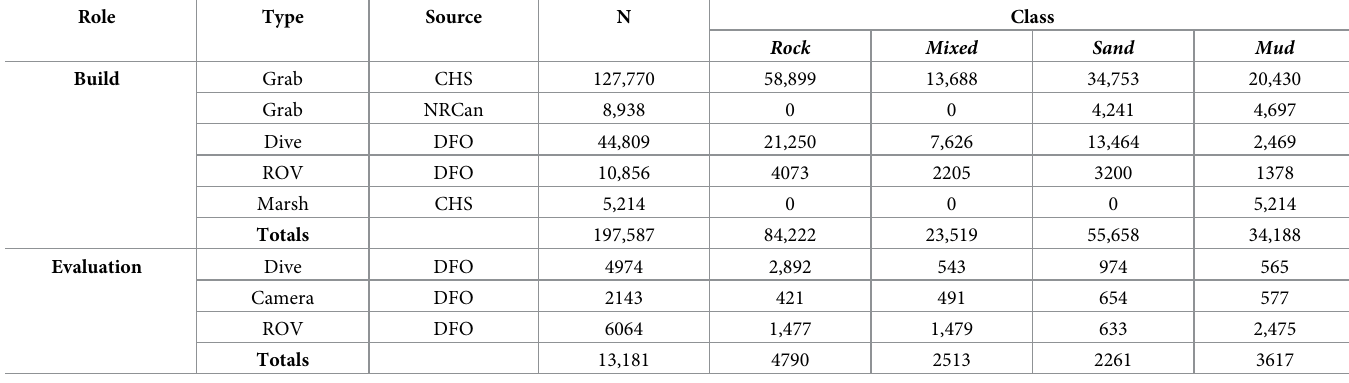
Table 1. Contents of the build data set showing number of observations (total and by substrate class) available for model development (build) and independent model evaluation.